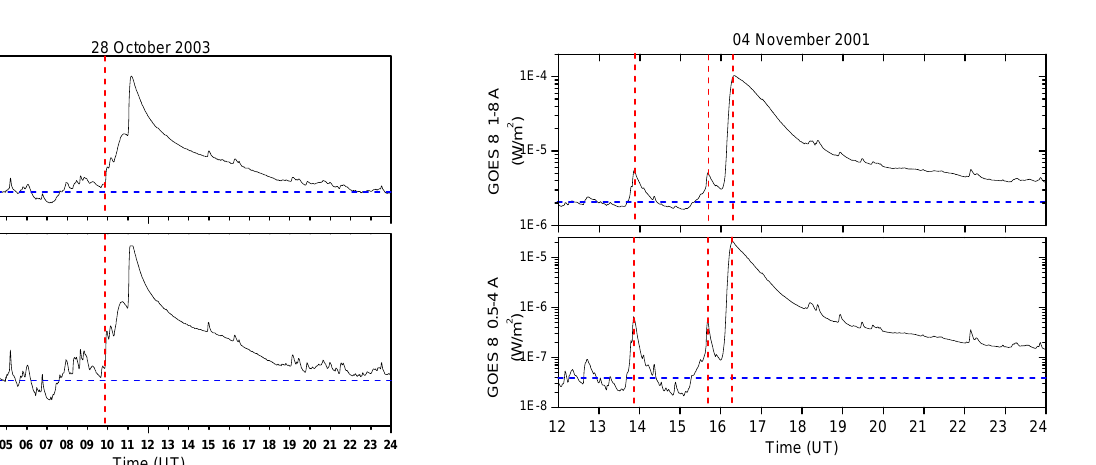
Fig. 5. Shows X-ray flux (1–8A and 0.5–4A) observed on 28 Oc- tober 2003 by the satellite GEOS 12 from 00:00 UT to 24:00 UT. The blue horizontal line indicates the quiescent X-ray flux. The red vertical lines indicates the onset of solar flare X-ray flux.